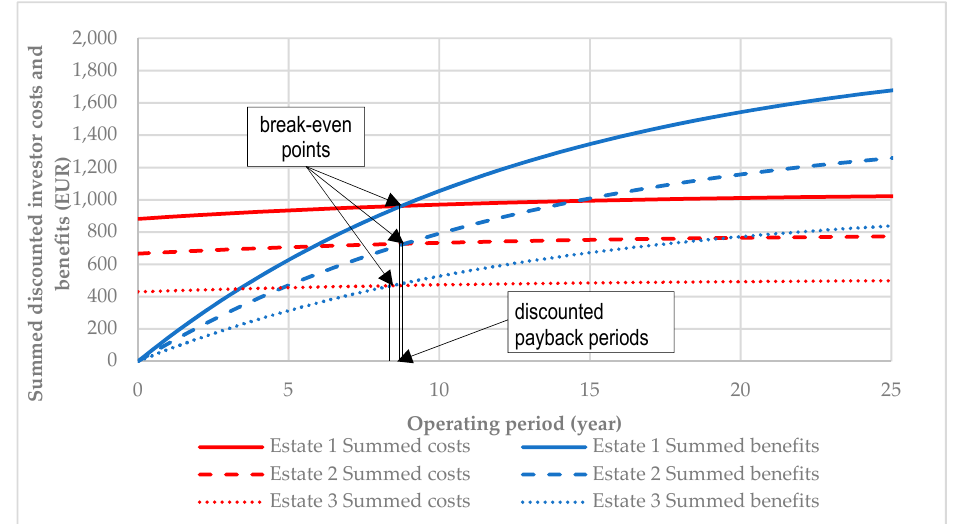
Figure 3. Summary discounted costs and benefits of minimalistic scenario for estate 1, 2, and 3 in Pozna ń .